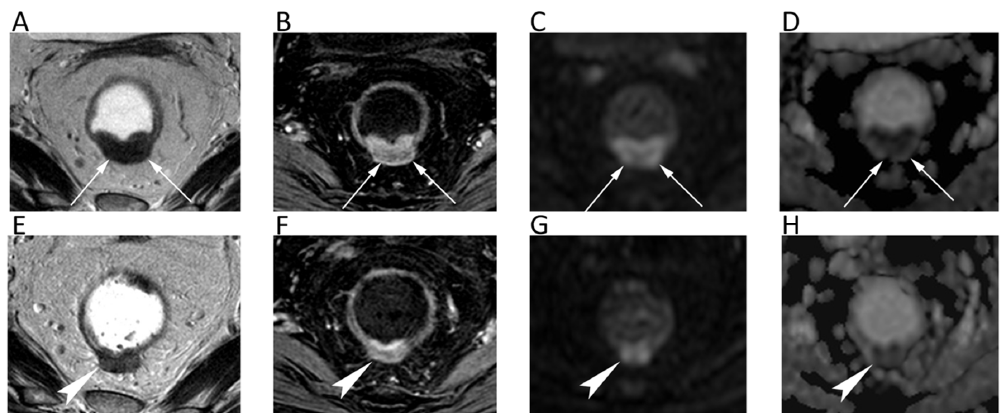
Figure 7. MRI scans of a 66-year-old female patient with rectal cancer at the initial diagnosis and two months later after neoadjuvant chemotherapy. Axial T2w image ( A ) and axial post-contrast fat-suppressed 3D GRE T1w image ( B ) show the tumor along the posterior rectal wall (arrows) with high signal intensity on the axial b = 600 DWI image ( C ) and low ADC (mean ADC: 0.651 × 10 − 3 mm 2 / s) on the corresponding ADC map ( D ). Post-treatment axial T2w image ( E ) shows the reduction in size of the lesion (arrowheads) with decrease of contrast enhancement ( F ) and slight increase of ADC values ( G , H ).